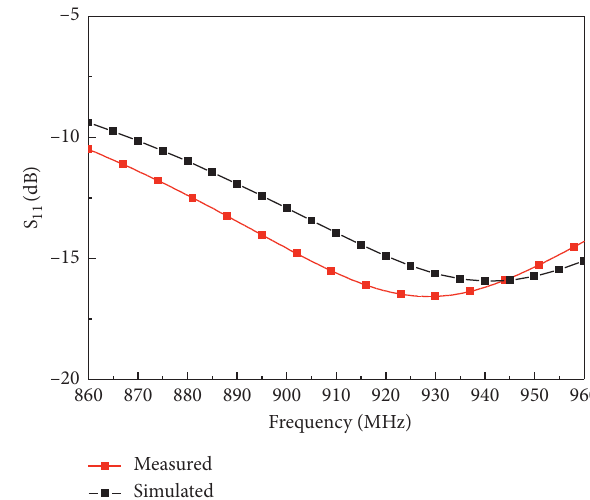
Figure 4: Simulated and measured reflection coefficients of the three-branch antenna.